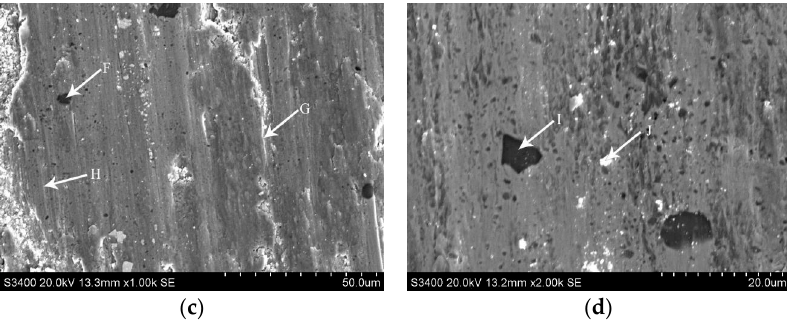
Figure 11. Worn morphologies of surface: ( a ) NiCr–5TiB 2 –5ZrB 2 ; ( b ) NiCr–10TiB 2 –10ZrB 2 ; ( c ) NiCr– 15TiB 2 –15ZrB 2 ; and ( d ) higher magnification image NiCr–15TiB 2 –15ZrB 2 . Table 4. Chemical composition (at.%) in different regions in Figure 11. Table 4. Chemical composition (at.%) in different regions in Figure